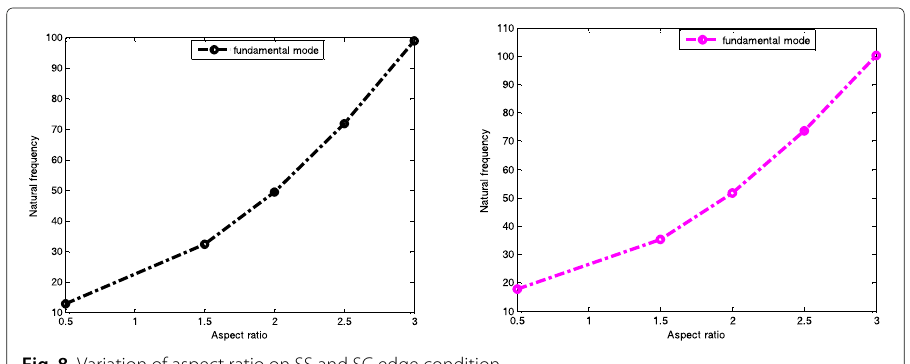
Fig. 8 Variation of aspect ratio on SS and SC edge condition